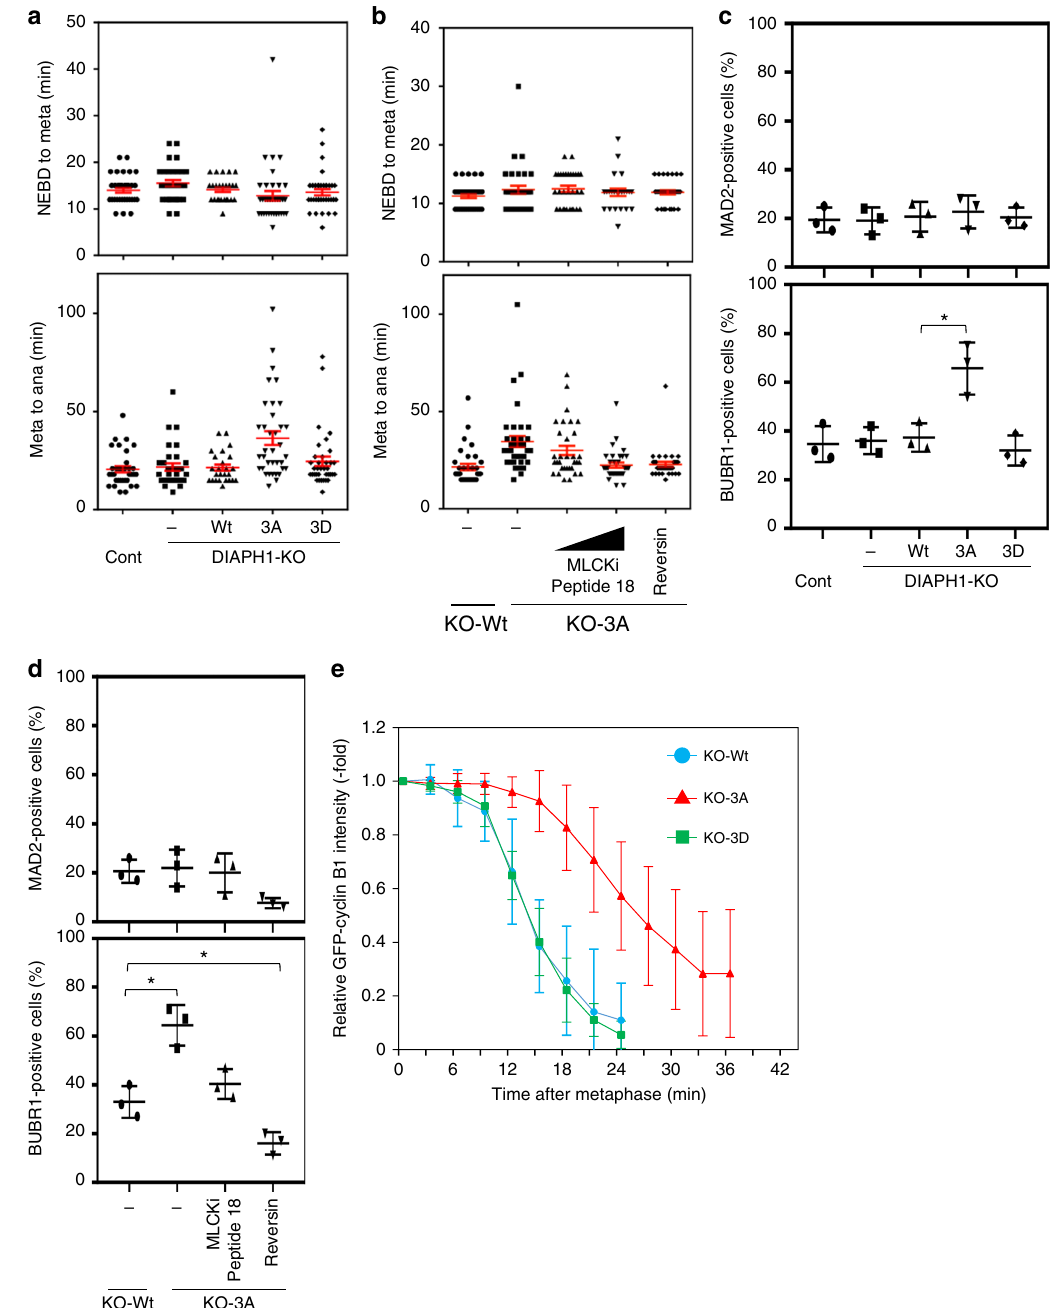
Fig. 5 Proper anaphase onset requires DIAPH1 phosphorylation through inactivation of SAC. a Control (Cont) or H2B-mCherry-KO-Wt, − 3A, or − 3D cells were imaged by time-lapse microscopy every 3 min. The time interval between NEBD and metaphase or metaphase and anaphase was determined. Cont: n = 33, DIAPH1-KO: n = 30, KO-Wt: n = 24, KO-3A: n = 34, KO-3D: n = 34. Red bars indicate means± SE. b H2B-mCherry-KO-Wt or − 3A cells were treated with or without MLCK inhibitor peptide 18 (2 or 5 μ M) or reversine (500 nM) for 30 min, and then imaged by time-lapse microscopy every 3 min. Wt: n = 33, 3A: n = 35 (2 μ M MLCK inhibitor peptide 18) and n = 30 (5 μ M MLCK inhibitor peptide 18), n = 25 (500 nM reversine). Durations were determined as in a and red bars indicate means ± SE. c Control (Cont) or KO-Wt, − 3A, or − 3D cells were stained with anti-MAD2 or anti-BUBR1 together with CREST antibodies. The number of metaphase cells showing co-localization of MAD2 or BUBR1 with CREST was counted (each n = 200). The results were obtained from three independent experiments. Bars indicate means ± SD. Statistical signi fi cance was determined by Student ’ s t -test. * p < 0.05. d KO- Wt or − 3A cells were treated with or without MLCK inhibitor peptide 18 (5 μ M) or reversine (500 nM) for 30 min, and analyzed as in a (each n = 200). The results were obtained from three independent experiments and analyzed as in c . * p < 0.05. e GFP-cyclin B-KO-Wt, − 3A, or − 3D cells were analyzed by time-lapse microscopy every 3 min. Fluorescence intensities of cyclin B1-EGFP were measured during metaphase progression (each n = 15), and the mean ± SD was plotted for each time point. Levels of fl uorescence were normalized to the fl uorescent values obtained at the metaphase